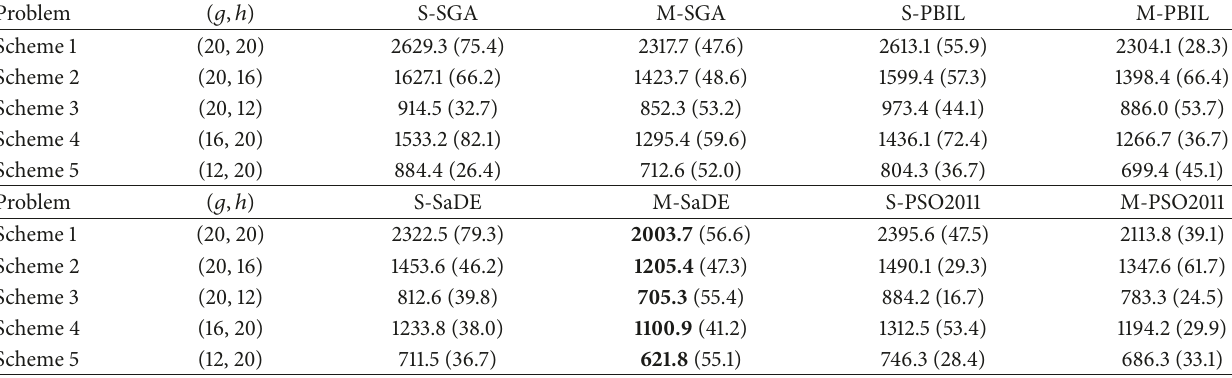
Table 5: Optimization results for 5 schemes of the warehouse scheduling problem. Here 𝑎(𝑏) denotes the mean value and corresponding standard deviation of the scheduling quality effect. The best results in each row are shown in boldface